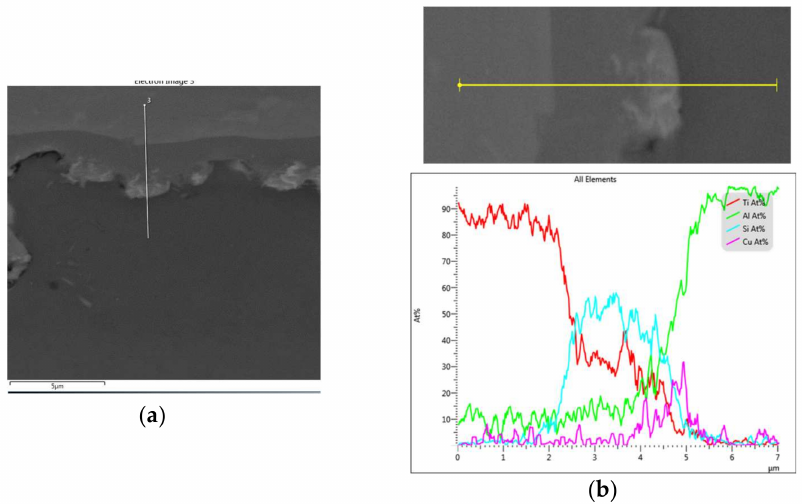
Figure 20. ( a ) SEM images (SEI) of a brazed joint (9-3/580) at the active part interface with the filler; ( b ) EDS line position and analysis of the interface in ( a